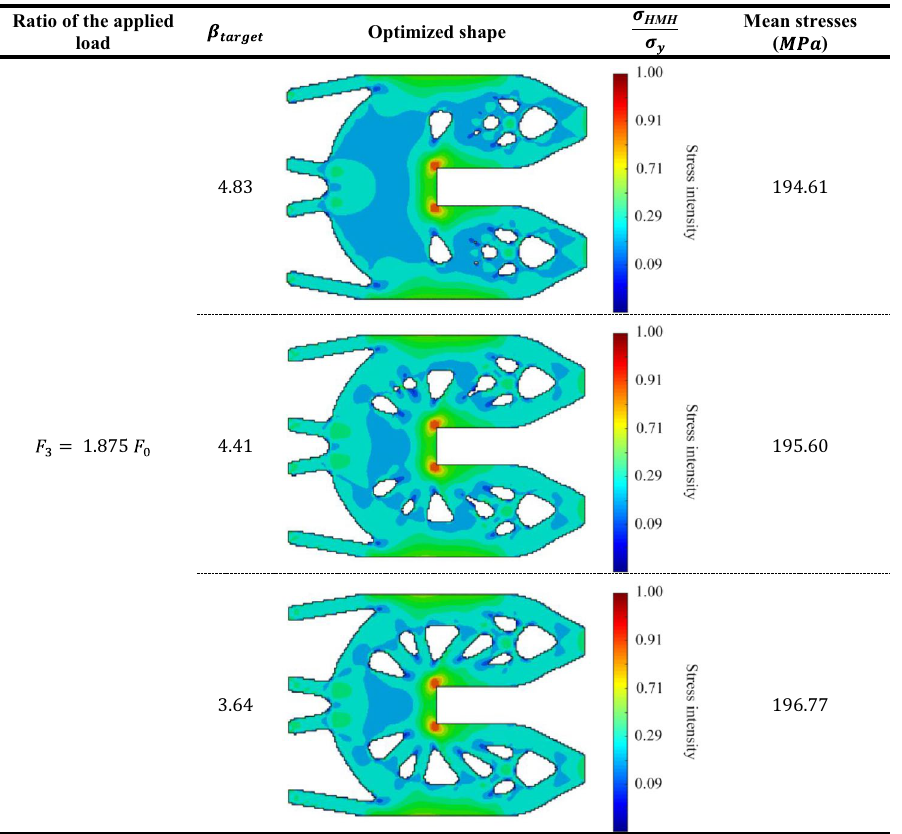
Table 9. HMH stresses and optimum topologies according to various load